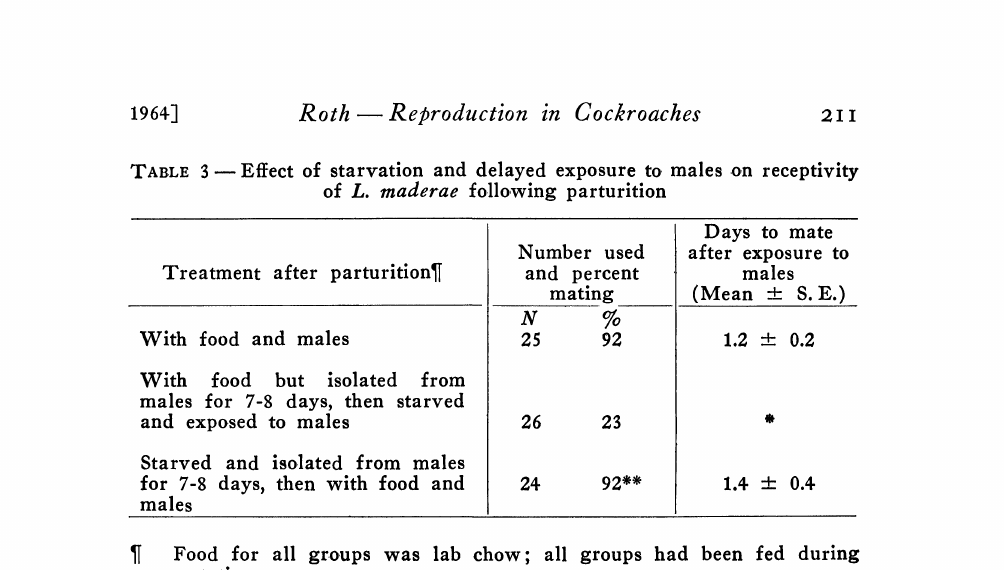
Days to mate after exposure to Number used males and percent (Mean +__ S.E.) mating 25 92 1.2 +/- 0.2 26 23 24 92** 1.4 +